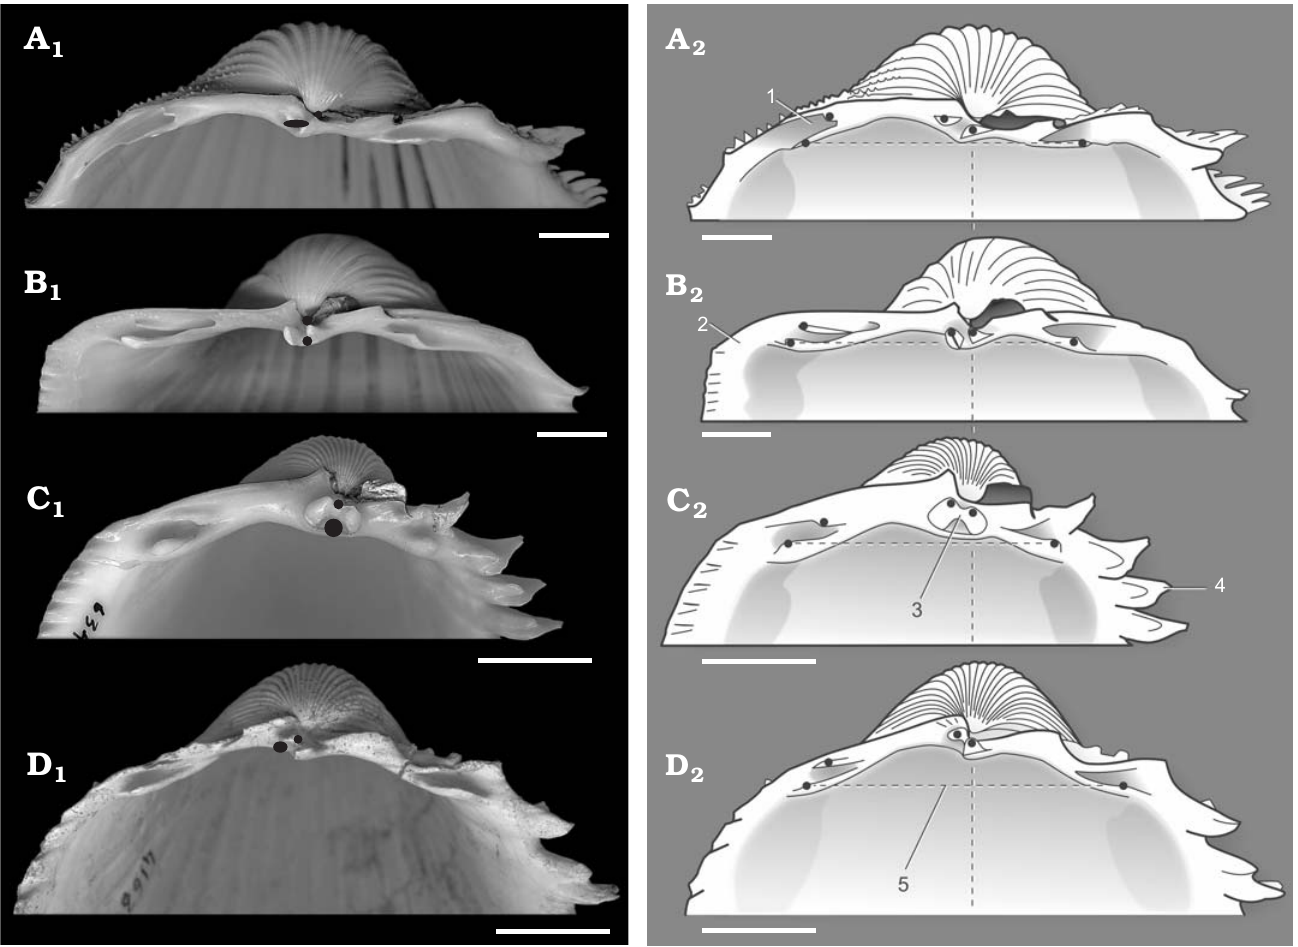
Fig. 2. Hinge region of the right valve of Cardiinae type species and a related “ Cardium ” species. A . Procardium indicum (Lamarck, 1819), RMNH.5006726 (ter Poorten collection), Recent, Algeria. B . Cardium costatum Linnaeus, 1758, RMNH.5006725 (ter Poorten collection), Recent, Angola. C . Bucardium ringens (Bruguière, 1789), RMNH.5006724 (ter Poorten collection), Recent, Senegal. D . “ Cardium ” burdigalinum (Lamarck, 1819), RGM.1309989 (ter Poorten collection), France, Léognan, Le Coquillat, early Miocene. Solid circles and ovals indicating positions of the tips of the teeth (A 2 –D 2 ) and the positions and shapes of the cardinal teeth of the opposite valve (A 1 –D 1 ). Note extremely hollowed anterior lateral socket in Procardium gen. nov. (1), angular antero-dorsal margin in Cardium (2), largely fused cardinals (3), strongly protuberant posterior ribs in Bucardium (4), and anterior and posterior ventral lateral teeth about equidistant from cardinals in “ Cardium ” (5). Scale bars 10